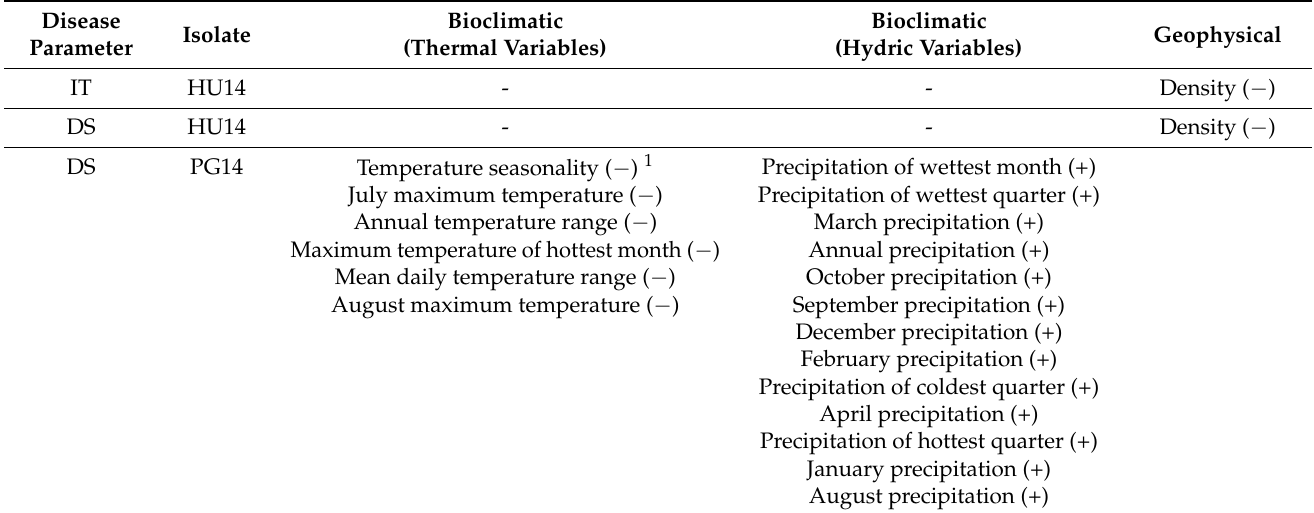
Table 2. Ecogeographical variables ordered according to their significant differences ( p < 0.05) between resistant (IT < 7 or DS ≤ 10) and susceptible landraces (IT ≥ 7 or DS > 10) to leaf rust at